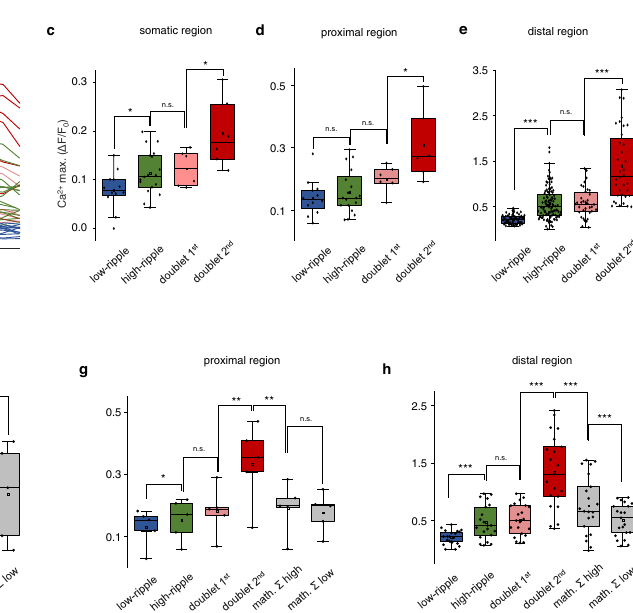
were recorded at submicron resolution using 3D ribbon scanning to precisely fol- low thin dendritic segments and then binned into 25 µ m intervals. In contrast